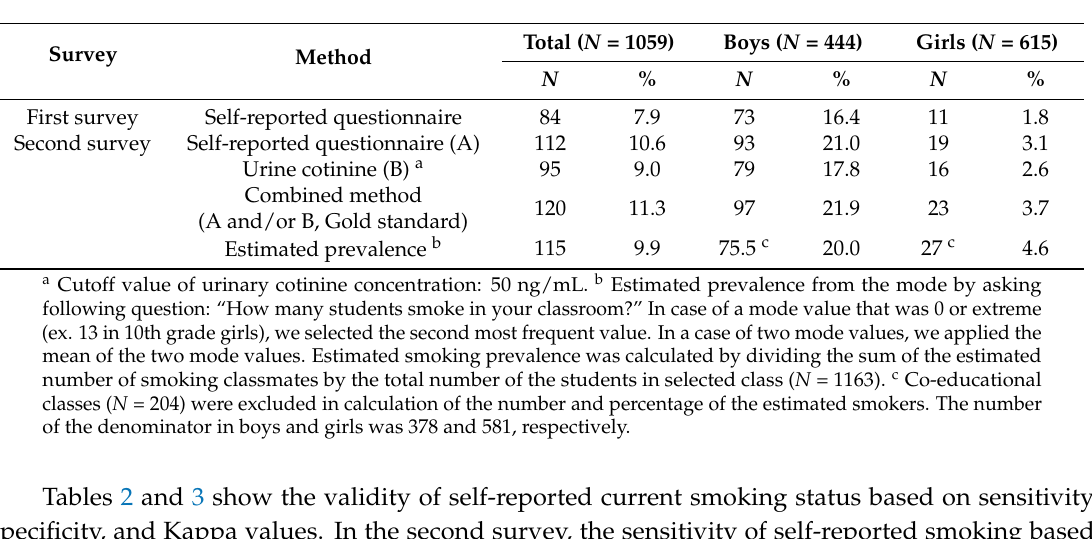
Table 1. Current cigarette smoking prevalence according to the survey